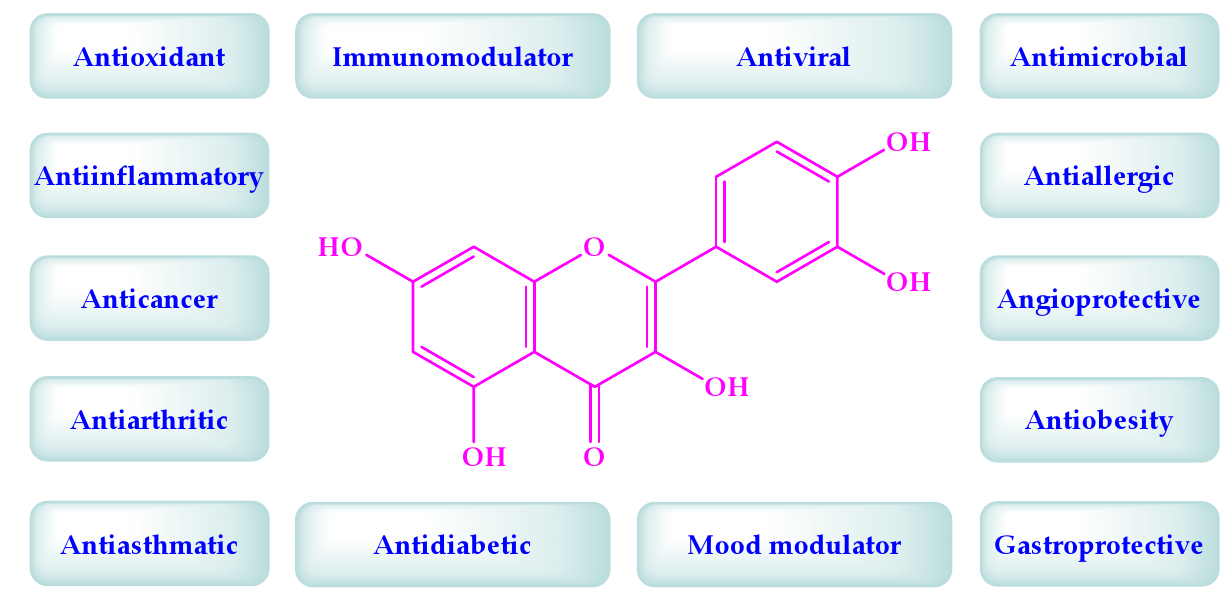
Figure 1. Chemical structure and biological effects of quercetin [18,21,22].